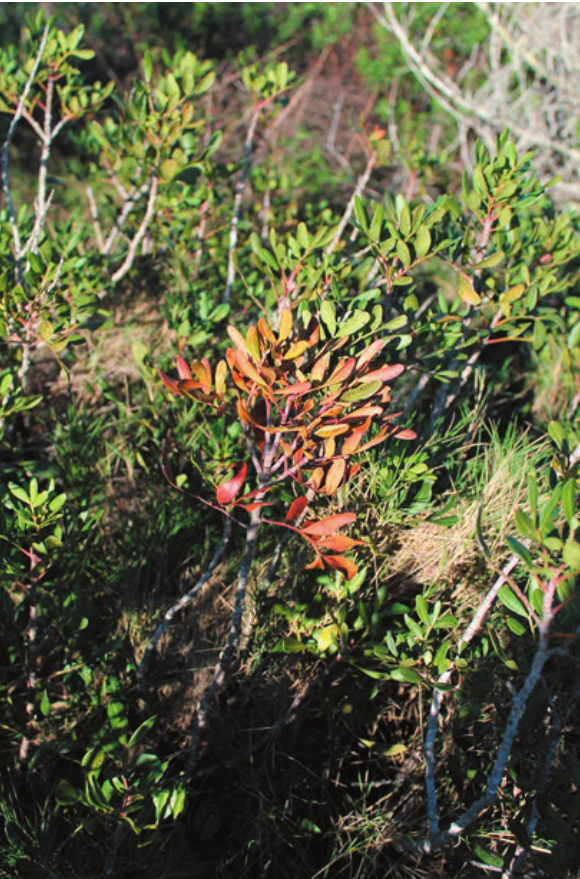
Figure 1. Foliar symptoms on lentisk shoots infected by Diplodia olivarum